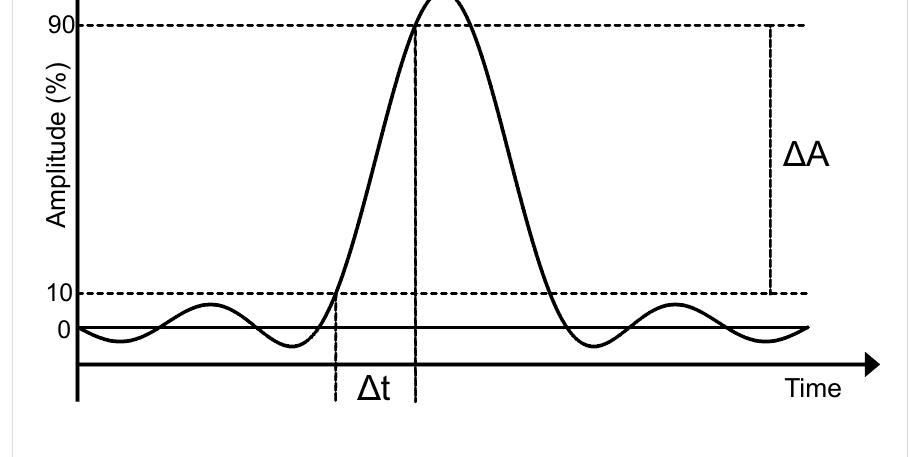
Figure A1. Positive-going transition.